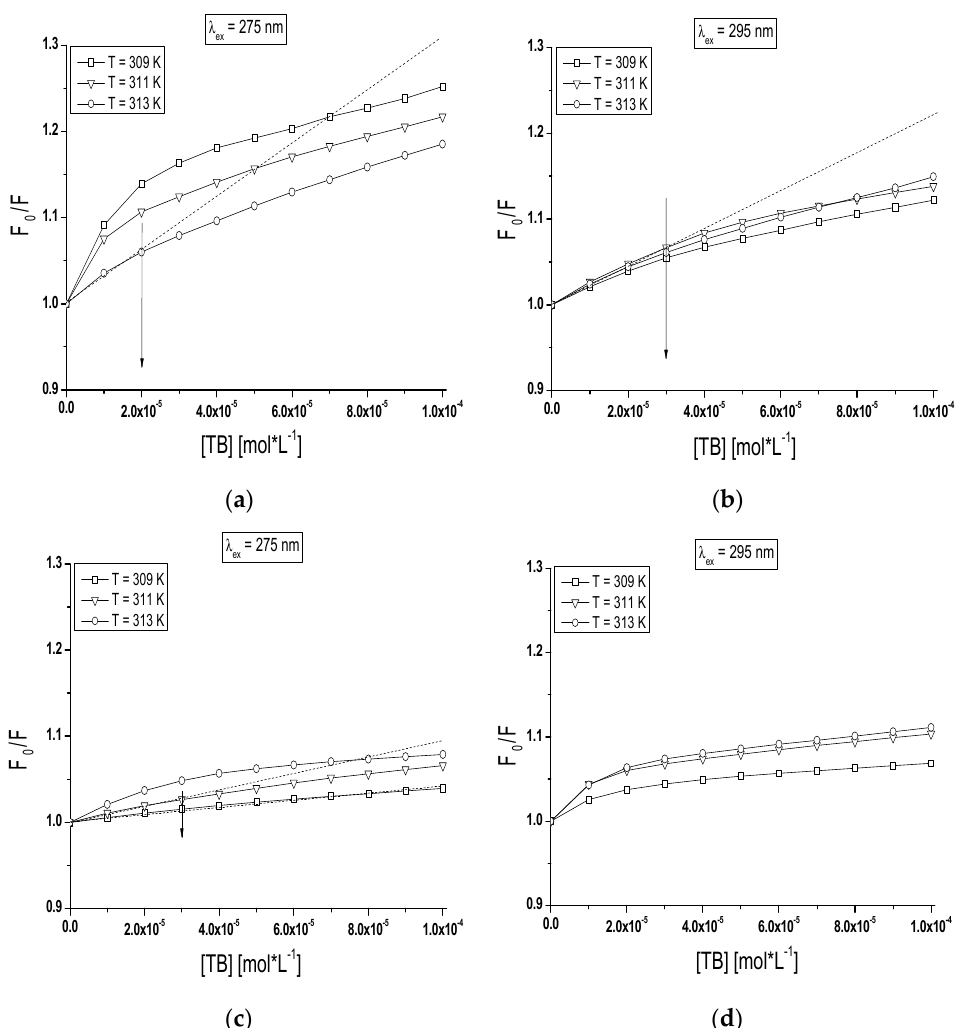
Figure 9. Comparison of the Stern-Volmer curves of F 0 vs. TB concentration (mol · L − 1 ) for: ( a , b ) TB-BSA; and ( c , d ) TB-gBSA complex in the temperature range between 309 K and 313 K; ( a , c ) λ ex = 275 nm; and ( b , d ) λ ex = 295 nm. The error bars are smaller than the symbols.